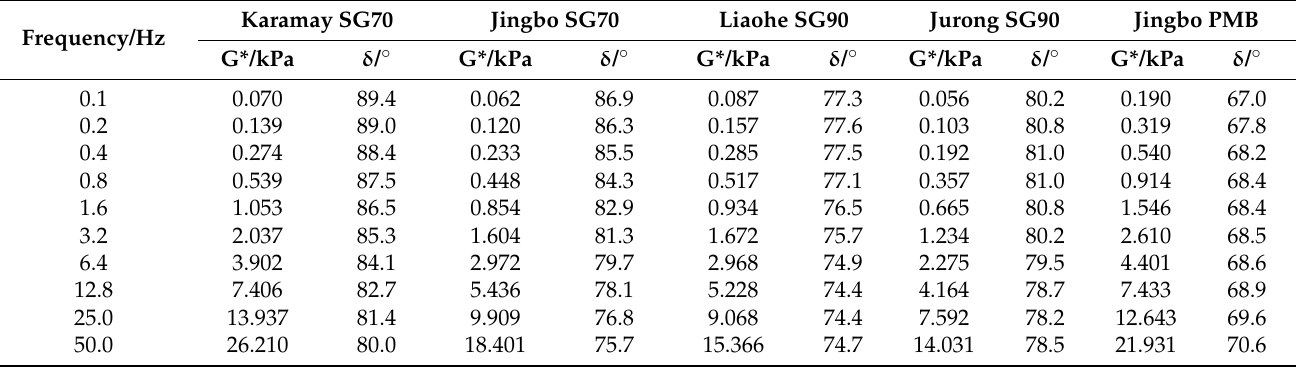
Table 4. The complex modulus (G*) and phase angle ( δ ) of five hydraulic bitumen binders at 70 ◦